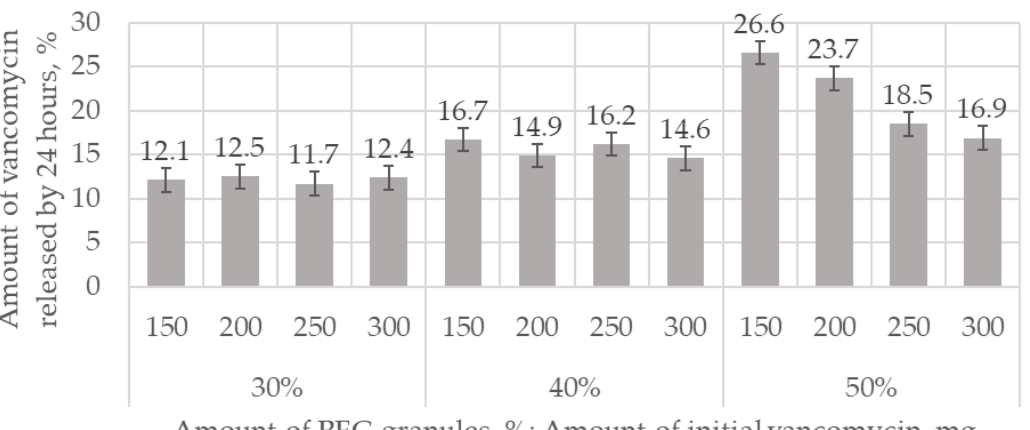
Figure 12. The amount of vancomycin released into the solution from the initial content by 24 h, wt.%.